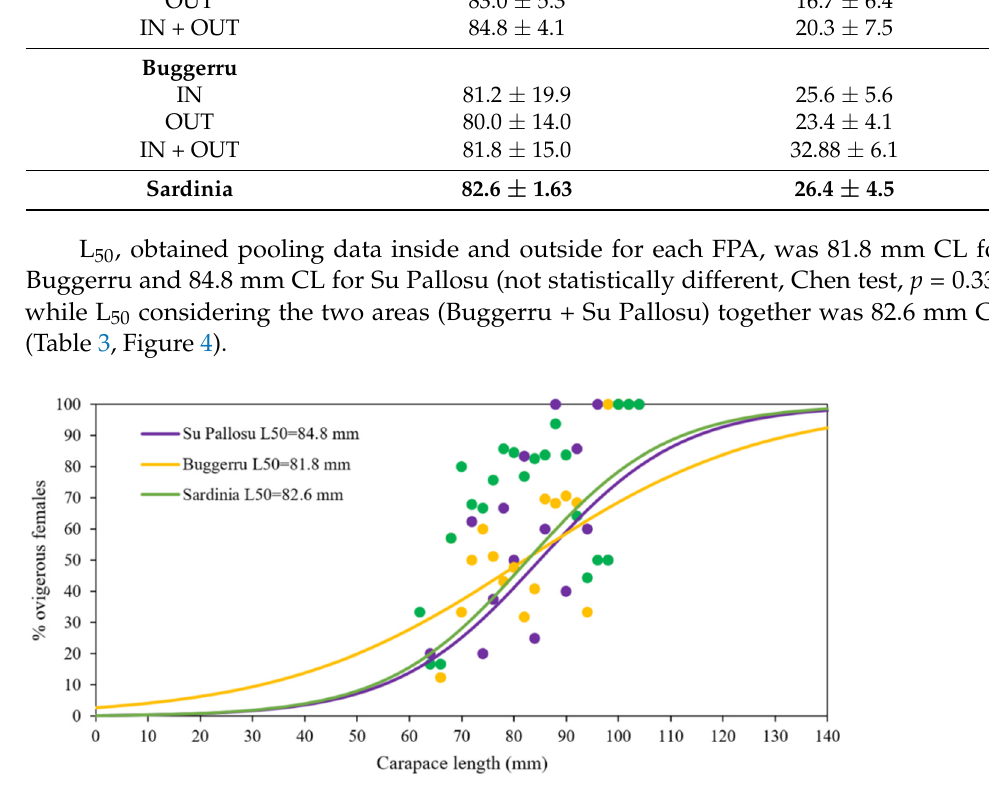
Figure 4. Proportion of P. elephas ovigerous females in each class of Carapace length (2 mm CL) estimated for Su Pallosu, Buggerru and the two areas combined together (Sardinia).